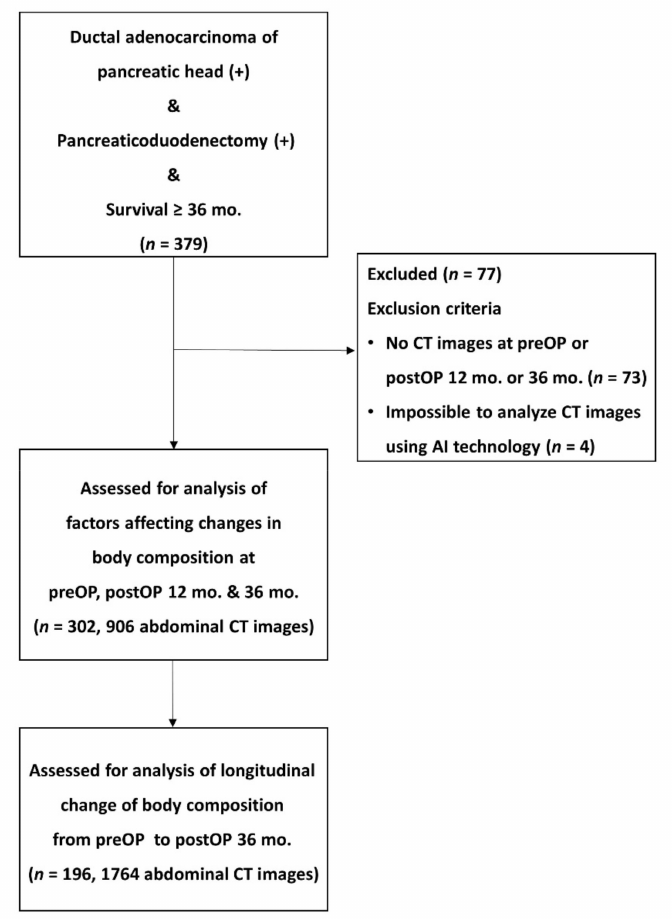
Figure 1. Flow diagram of study selection. CT = computed